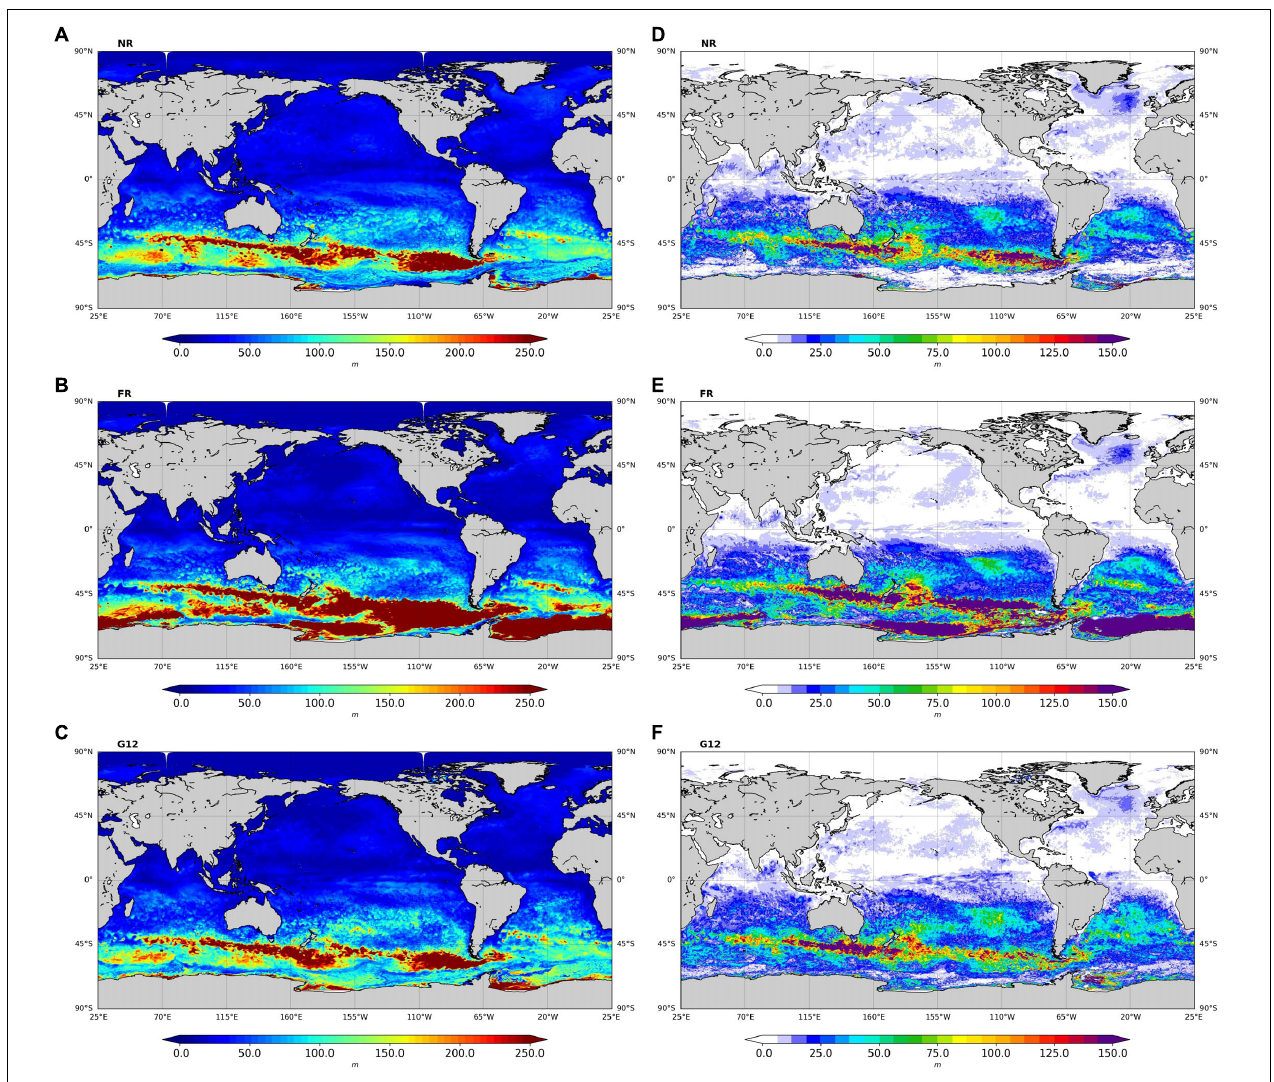
FIGURE 5 | Mean and Standard deviation of the MLD (September 2015); Mean: NR (A) , FR (B) , and G12 (C) ; Standard deviation: NR (D) , FR (E) , and G12 (F)